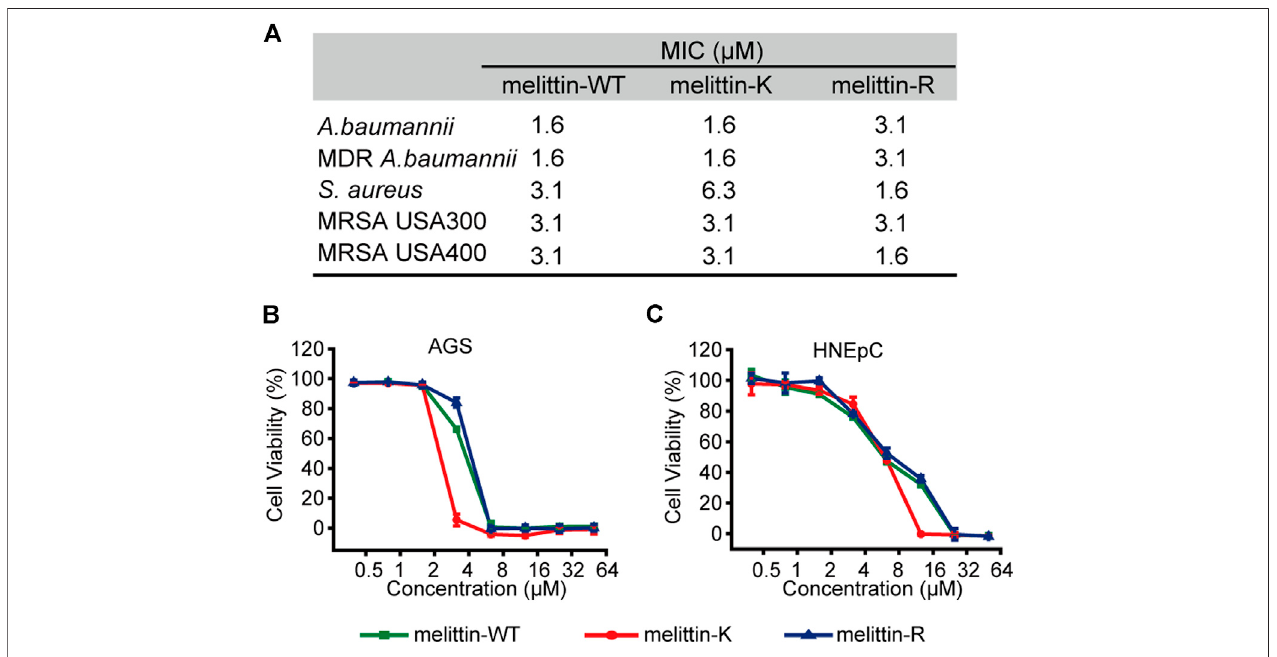
FIGURE4| Biologicalactivitiesofmelittins. (A) The MIC valuesofmelittinsagainstGram-negativebacteria(MDR A.baumannii 1814516and A.baumannii BAA747) and Gram-positive bacteria ( S. aureus 29231, MRSA USA-300, and MRSA USA-400). (B – C) The cytotoxicity of melittin peptides for AGS (B) and HNEpC cell lines (C) .